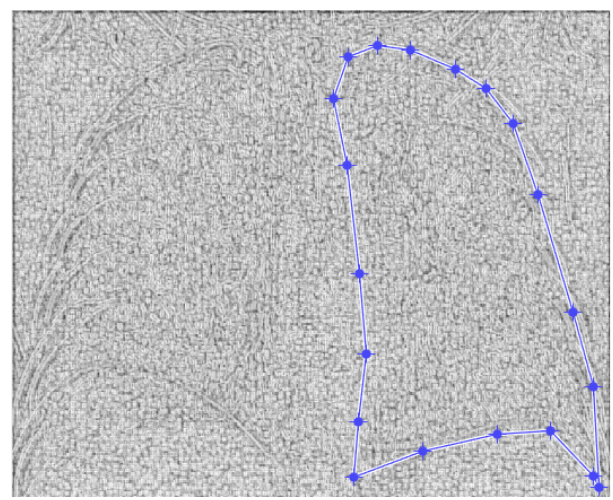
Figure 5. De fi ning the mask for the right lung of the fi rst patient. Figure 5. Defining the mask for the right lung of the first Table 1 shows the known fractal indicators, such as the fractal dimension of the CT image of the left lung, d 1L = 1.8781 ± 0.3251, and the lacunarity, Λ = 0.0300; and the fractal dimension of the right lung, d 1R = 1.8817 ± 0.3267, and the lacunarity, Λ = 0.0301. Table 1. Fractal indicators for the fi rst patient. 1. MT Date 9 March 2022